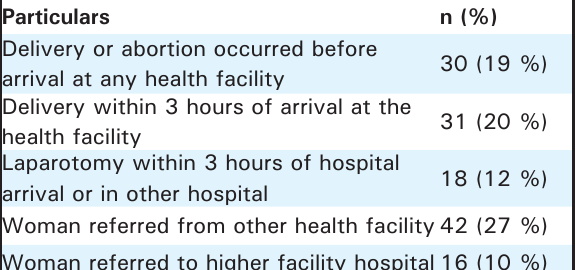
Table 6. Conditions at arrival in the facility and the referral